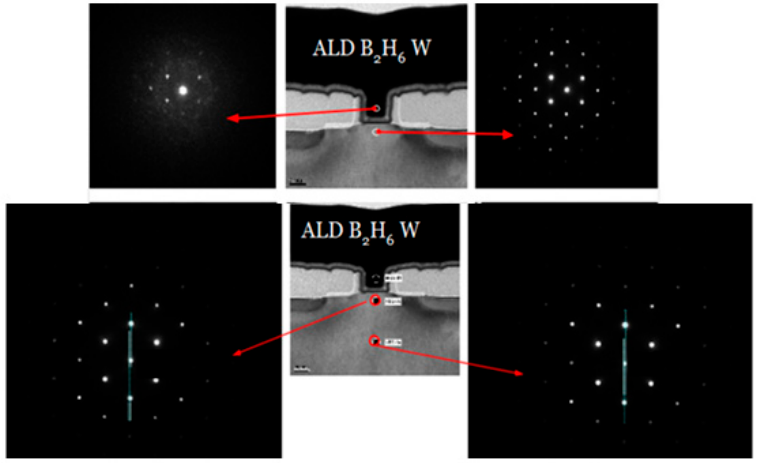
Figure 8. Nano-beam diffraction (NBD) micrographs from metal gate, channel and the body regions of a 22 nm planar transistor [52].